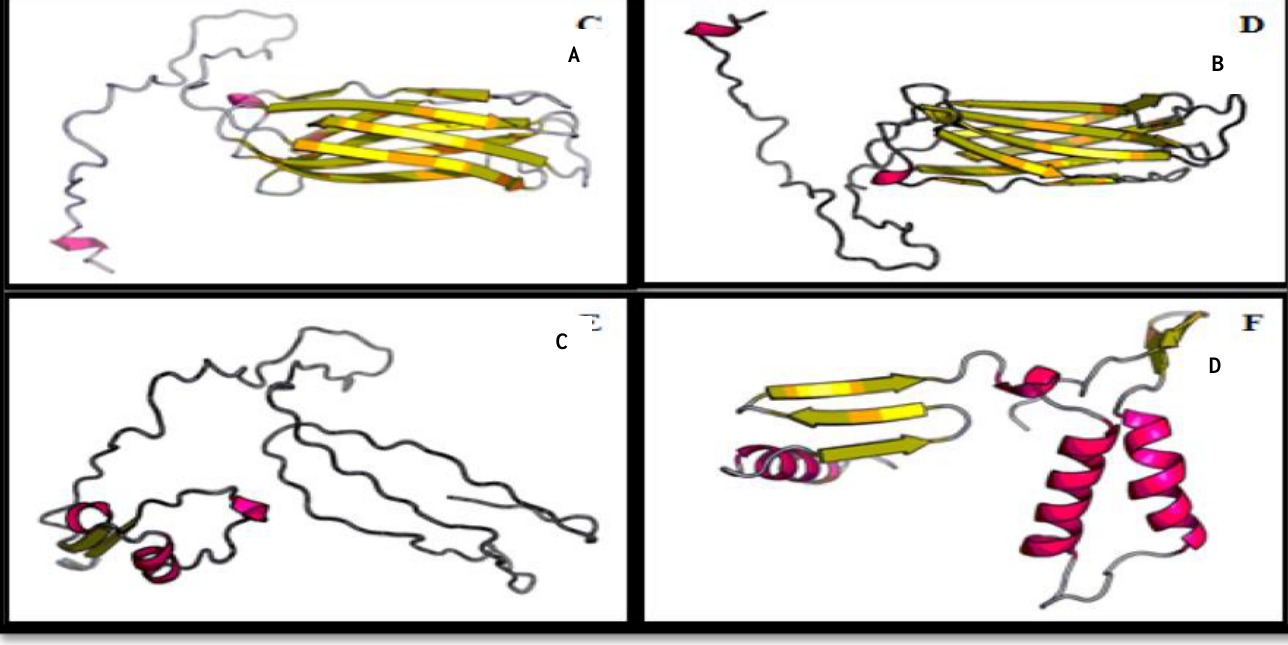
Figure 2. VP protein analysis: A) VP 2 in segment A, B) VP 2-3-4 in segment A, C) VP 5 in segment A and D) VP 1 in segment B for IBDV. Raptorx software was used for drawing structure protein (alpha-helixes, beta-sheets, and coils) of amino